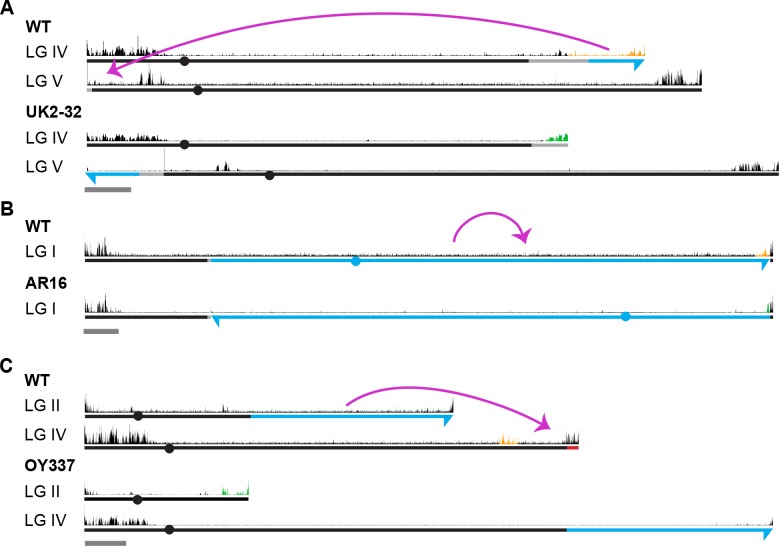
H3K27me2/3 profiles of additional strains containing chromosomal rearrangements.Chromosome rearrangements and H3K27me2/3 ChIP-seq (pooled biological triplicates) profiles are shown for translocations UK2-32 (A), AR16 (B) and OY337 (C). Magenta curved arrows illustrate the movement of chromosomal segments in the translocations. Blue and dashed lines distinguish chromosome sources while arrows indicate the directionality of translocated segments. Light gray lines highlight regions of uncertainty with respect to the locations of breakpoints based on available genetic evidence (see Materials and methods). Solid red line indicates chromosome deletions. H3K27me2/3 ChIP-seq tracks of WT and translocation strains are displayed above chromosome diagrams. H3K27me2/3 that was lost in a translocation strain is highlighted in orange in the corresponding WT track while new H3K27me2/3 is indicated in green. Conserved H3K27me2/3 is shown in black. Circles indicate centromeres. Dark gray bars indicate 500 kb.